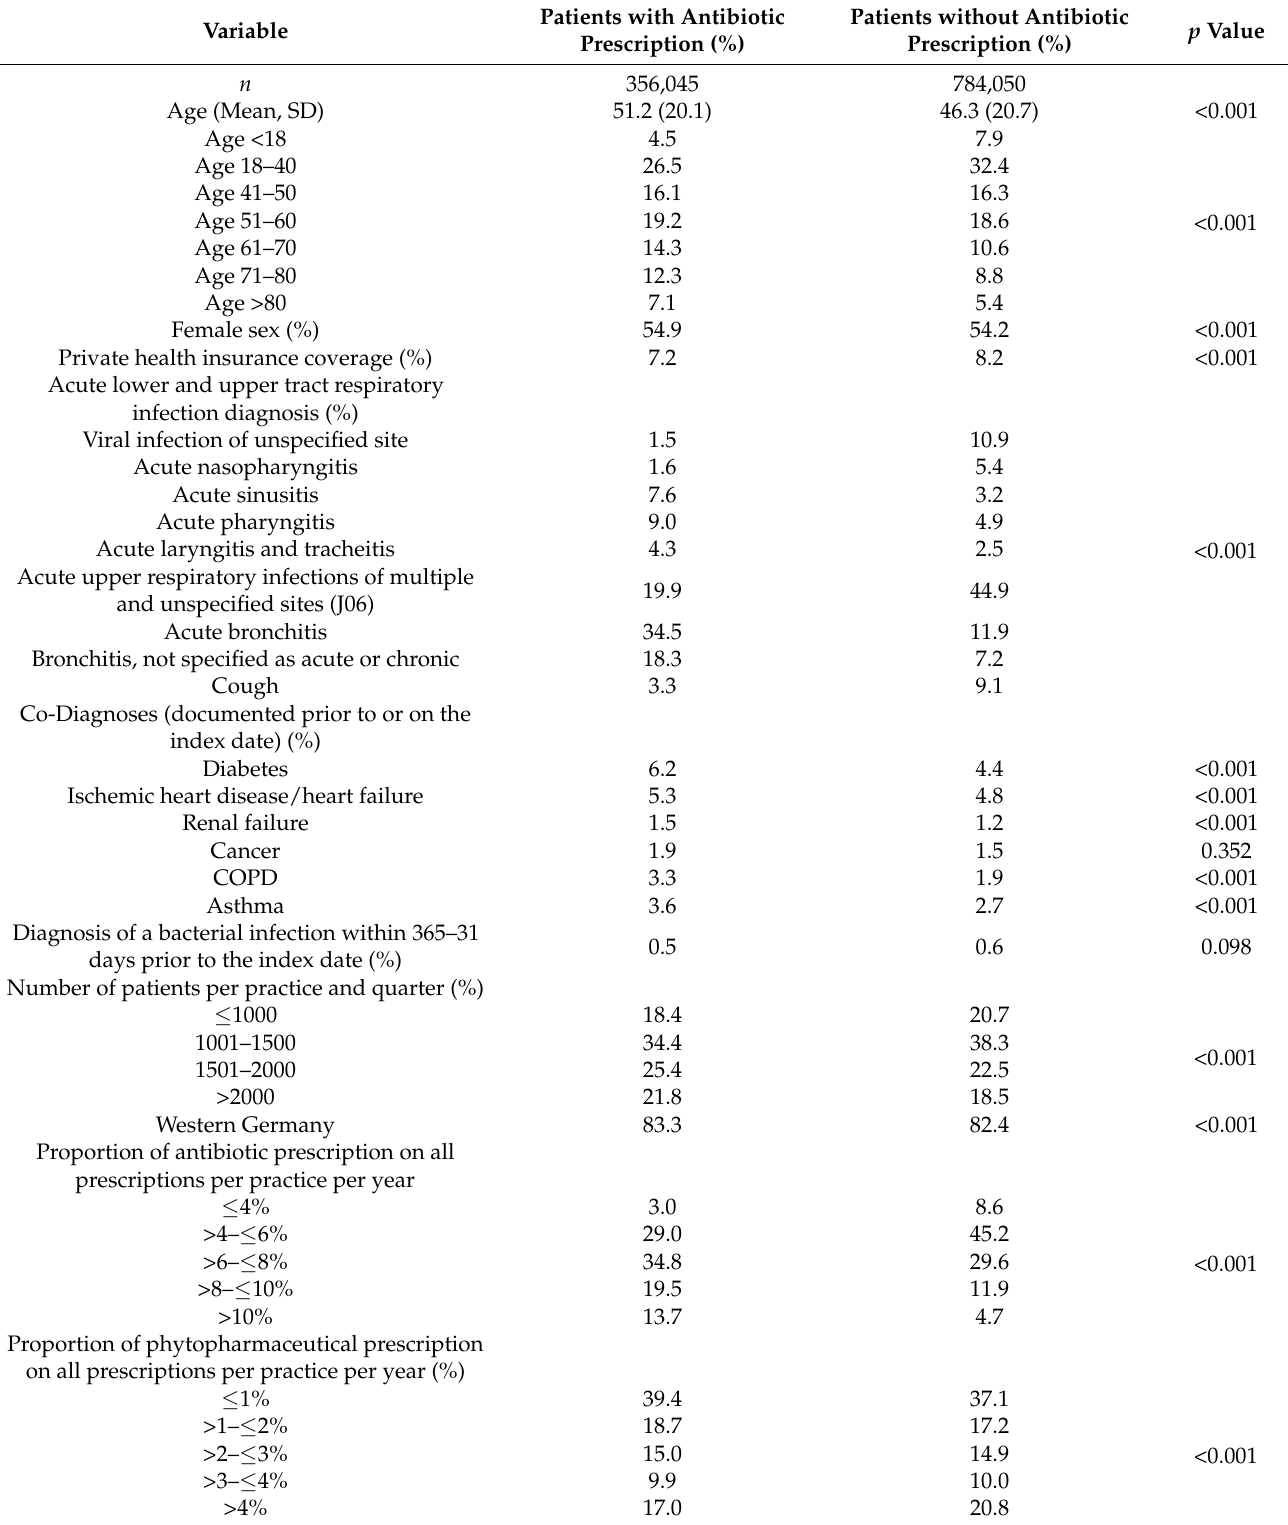
Table 1. Baseline characteristics of study patients in